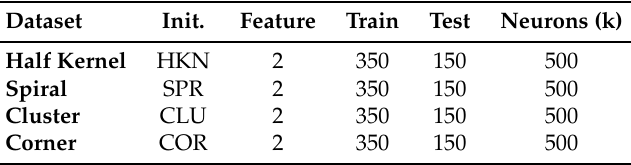
Table 1. Synthetic data set used in the experiments.